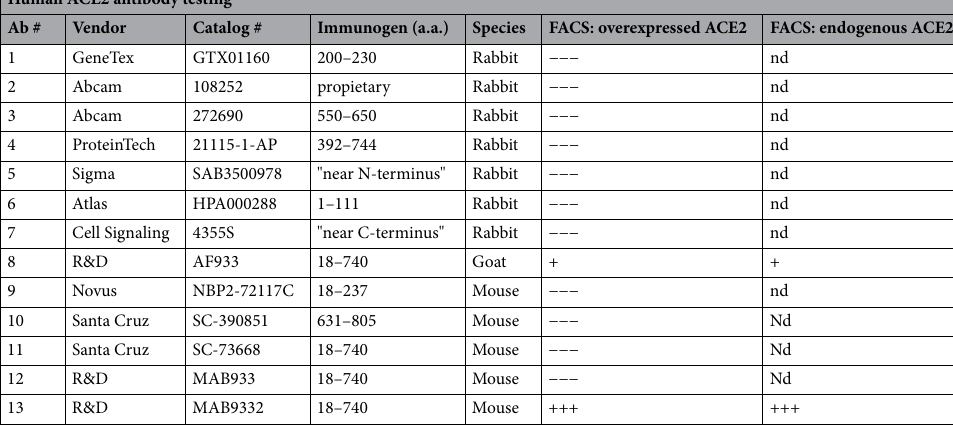
Table 1. Human ACE2 antibodies tested in this